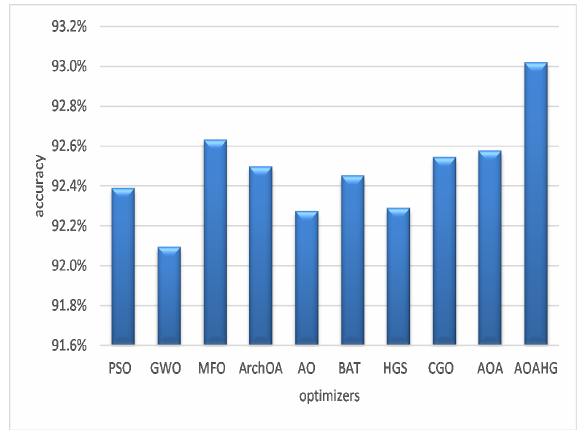
Figure 8. Average accuracy of the SVM across the